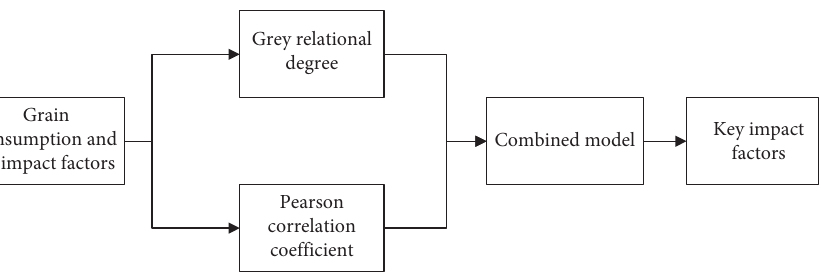
Figure 2: Selection of impact